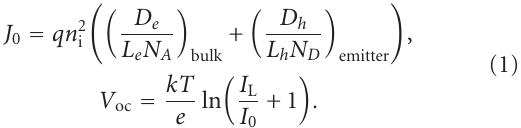
Figure 7: Bulk lifetime of bare wafers treated with annealing conditions measured using